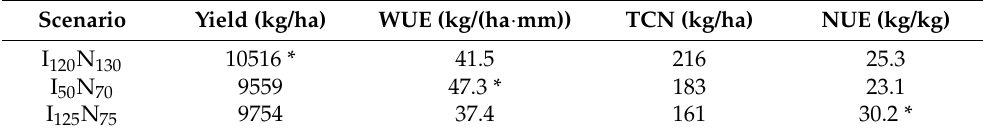
Table 5. Optimal SDF scenarios obtained by maximizing yield, WUE and NUE.